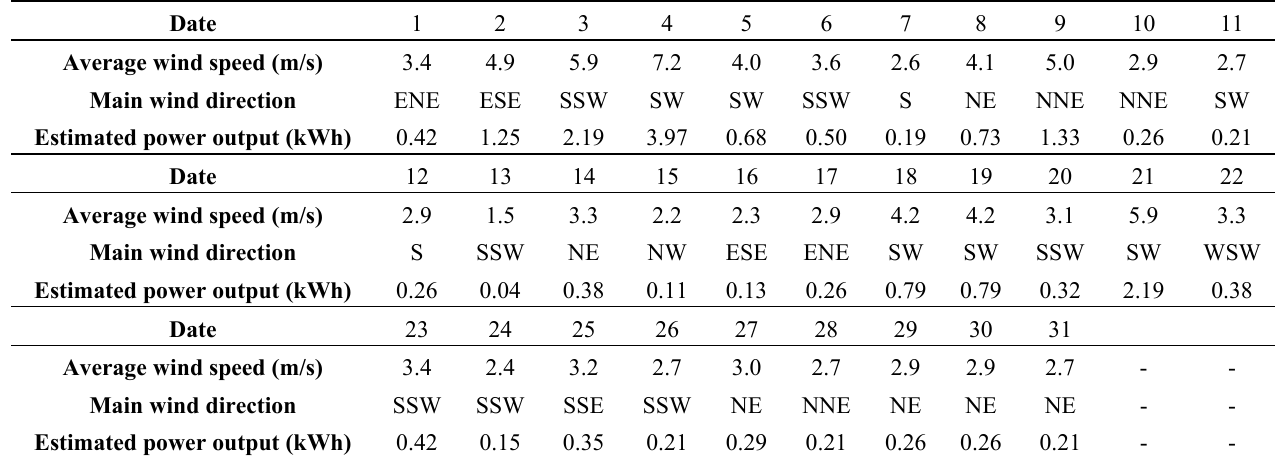
Table A8. Estimated power output per day in August.